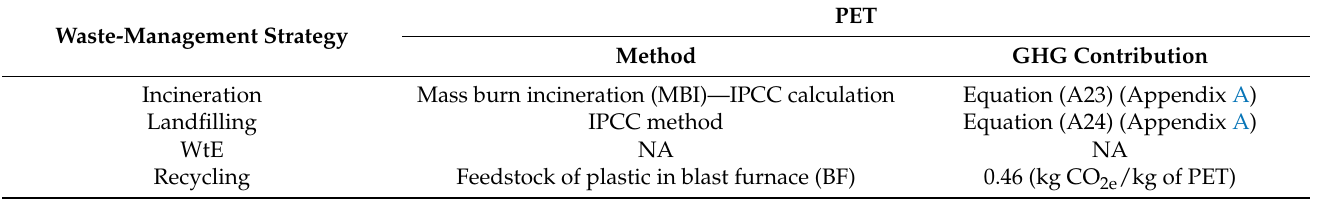
Table 33. PET waste-management technologies used